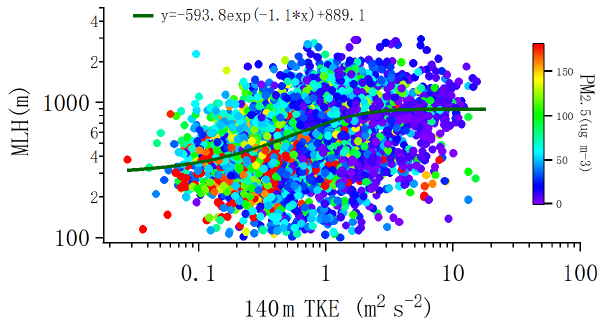
Figure 5. Turbulent kinetic energy at 140m as a function of mix- ing layer height and PM 2 . 5 concentrations at 120m from July 2009 to August 2011. An exponential function was fitted based on best